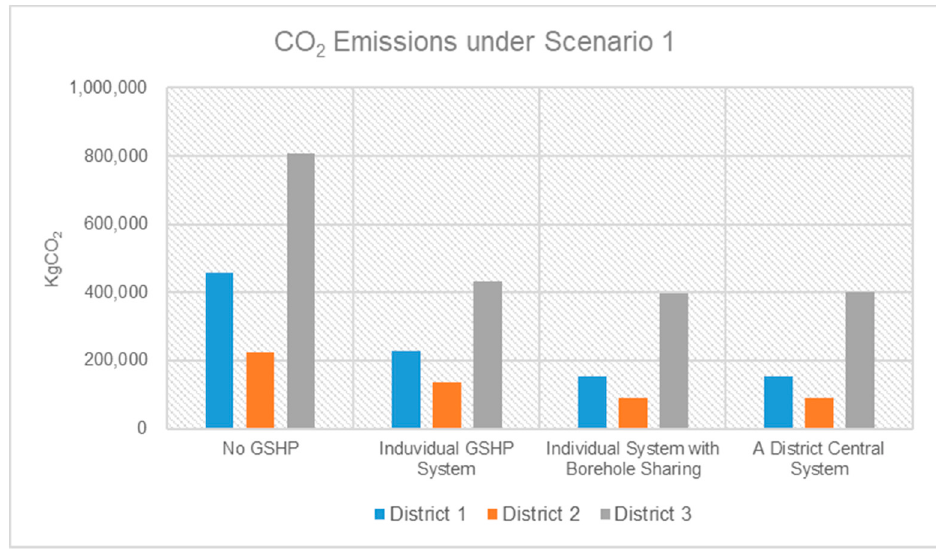
Figure 7. CO 2 emissions of district sharing systems (Scenario 1).